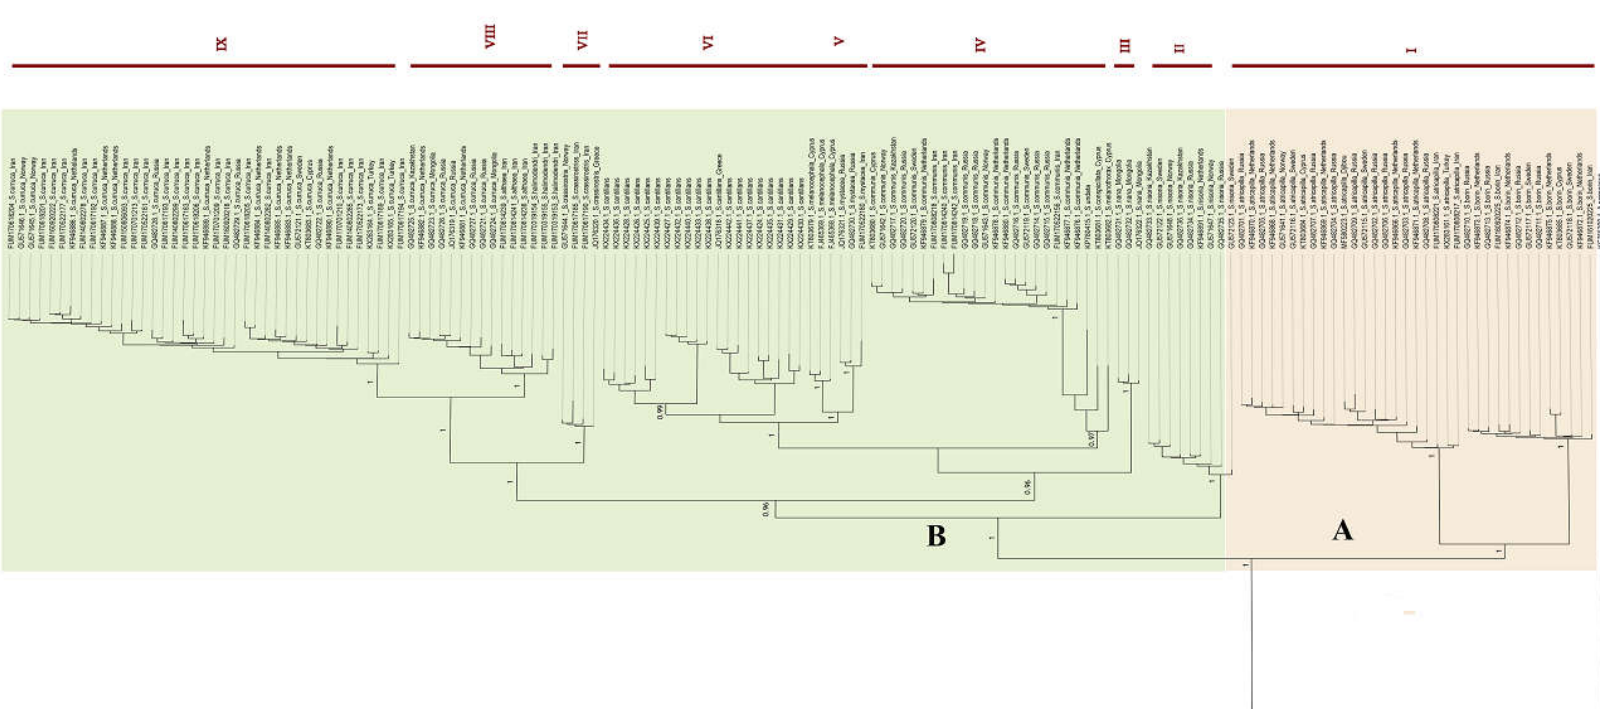
Fig. 3. Phylogeny of Sylvia warblers, based on Bayesian analyses of mitochondrial cox1 : Clade A) S. borin and S. atricapilla ; Clade B) All other species in Sylvia genus . The cytb analysis recovers eight groups (Greek